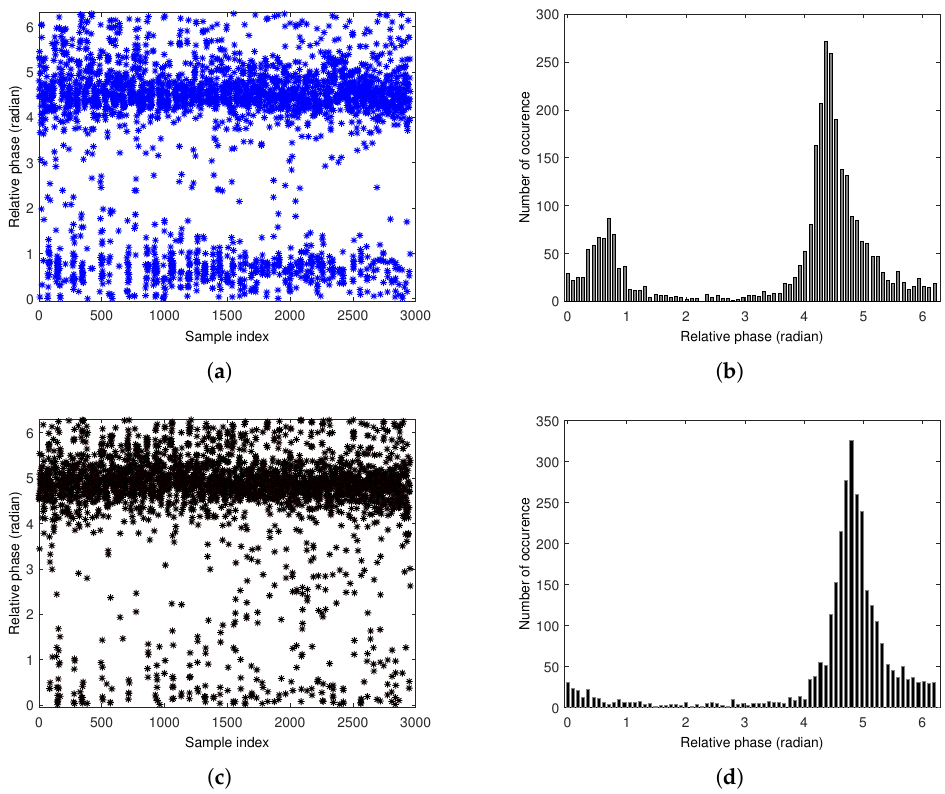
Figure A1. Typical distributions of the phase deviations deduced from a field experiment in OSMAR-S system. Following the definition of the phase deviation in Section 2, the phase deviations are equivalent to the phase difference of the first-order Bragg Doppler bins in the loops relative to those in the monopole. ( a ) the scatter plot of the phase deviation for cosine loop; ( b ) the histogram of the phase deviation for cosine loop; ( c ) scatter plot of the phase deviation for sine loop; ( d ) histogram of the phase deviation for sine